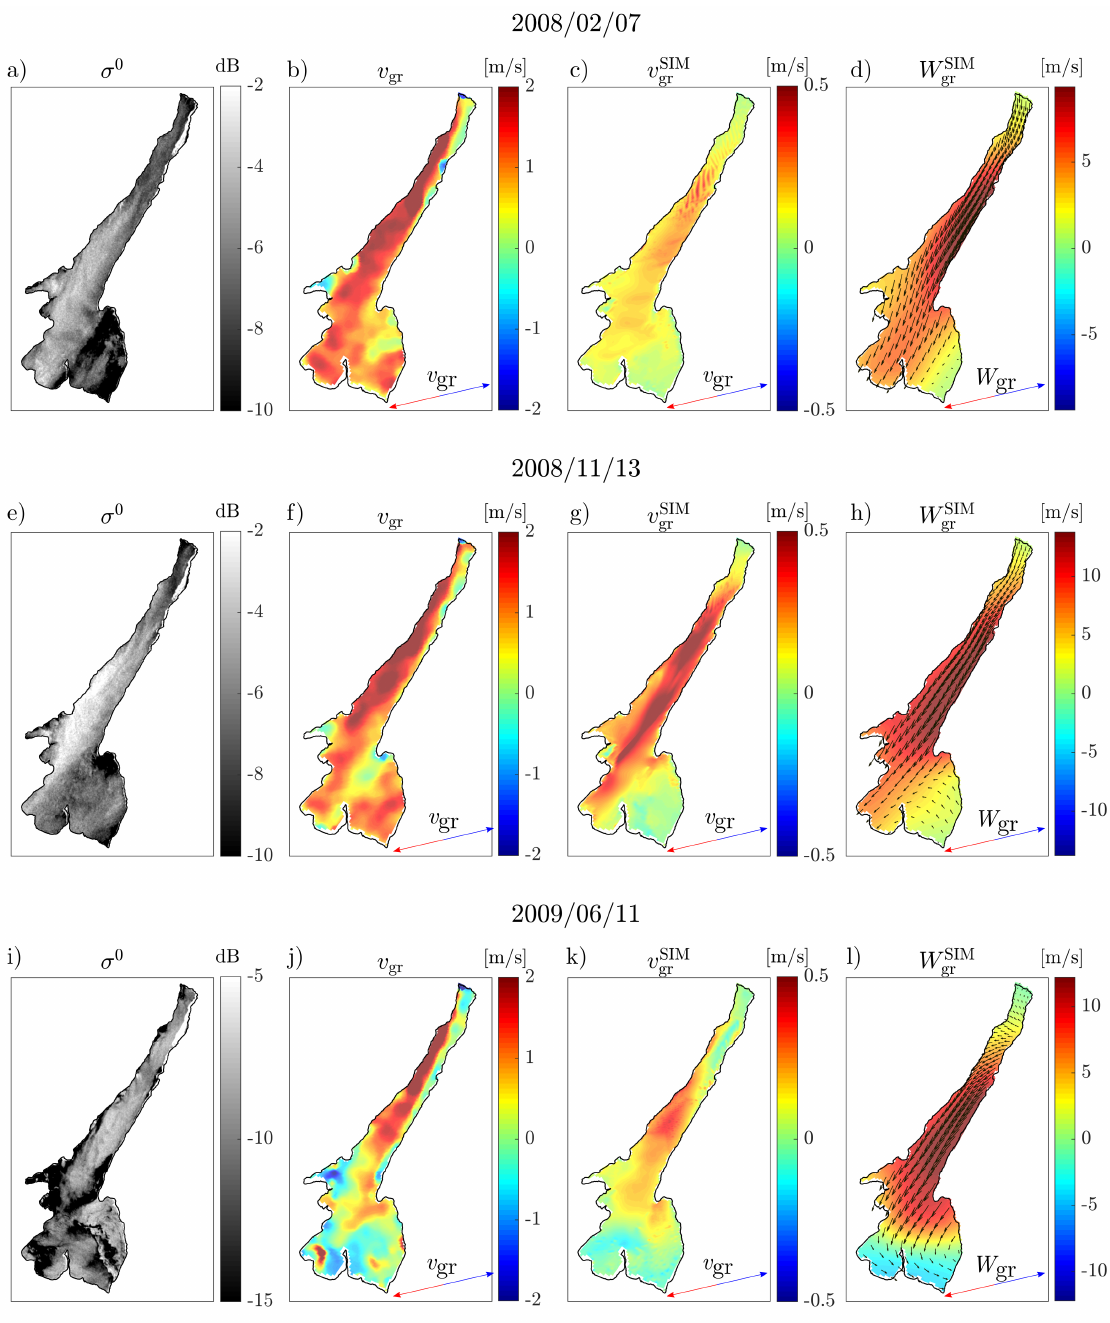
Figure 6. Maps from high wind days ( a – d ) 7 February 2008, ( e – h ) 13 November 2008, ( i – l ) 11 June 2009 of: first column ( a , e , i ) SAR backscatter amplitude; second column ( b , f , j ) v gr estimated from SAR DCA (Equation (2)); third column ( c , g , k ) v SIM gr simulated by the numerical model; fourth column ( d , h , l ) ground range component of simulated wind speed W SIM gr . Black arrows in fourth column indicate the wind vector. The ground range direction is displayed by the blue and red arrow at the bottom-right corner of the